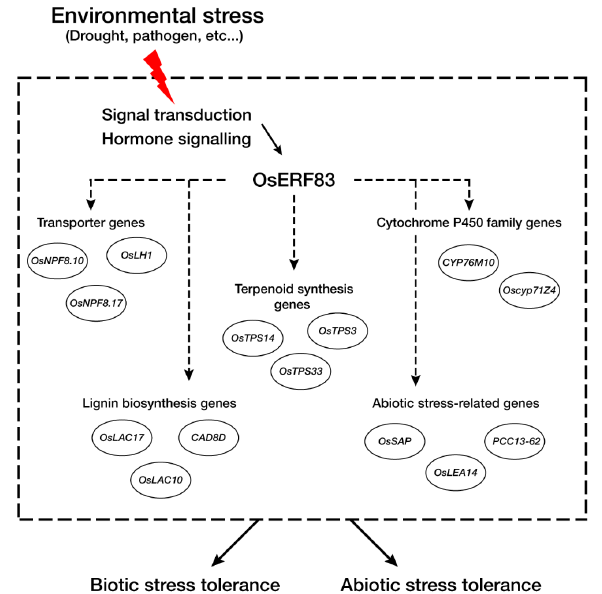
Figure 8. Schematic representation of OsERF83 -mediated stress tolerance. The rice recognizes the stress signal through a plant hormone signaling pathway, and OsERF83 is up-regulated in response to stresses. Transporter genes ( OsNPF.10, OsLH1, OsNPF8.17) , terpenoid synthesis genes ( OsTPS14, OsTPS33, OsTPS3 ), cytochrome P450 genes ( Oscyp71Z4, CYP76M10) , lignin biosynthesis genes ( OsLAC17, OsLAC10, CAD8D ), and abiotic stress-related genes ( OsSAP, OsLEA14, PCC13-62) were induced by OsERF83.